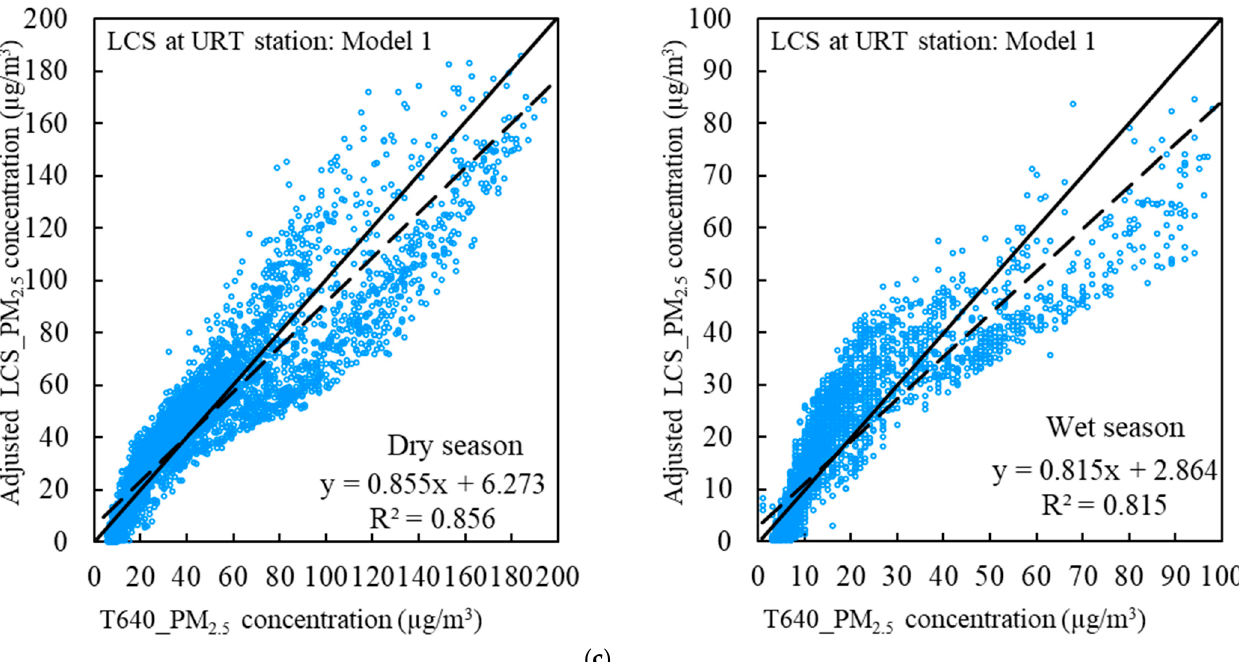
Figure 6. Correlation between LCS LR models and FEM values for 1-h PM 2.5 concentration during the dry and wet seasons at ( a ) CM, ( b ) BKK and ( c ) URT. The solid line is the line with slope =1 while the dashed line represents the fitting.